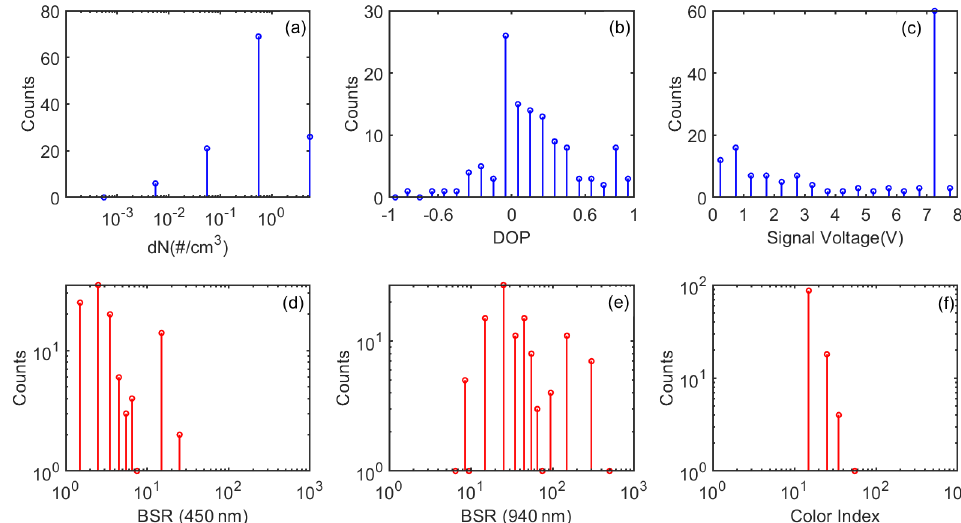
Figure 11. Histogram of (a) droplet number concentration (d N ) in no. per cc, (b) degree of polarization (DOP), (c) backscattered signal (volts), (d) backscatter ratio at 455nm, (e) backscatter ratio at 940nm, and (f) colour index. Panels (a–c) and panels (d–f) respectively show CPS data and COBALD data for the ice cloud layer between 9 and 11km from the sounding held on 27 June